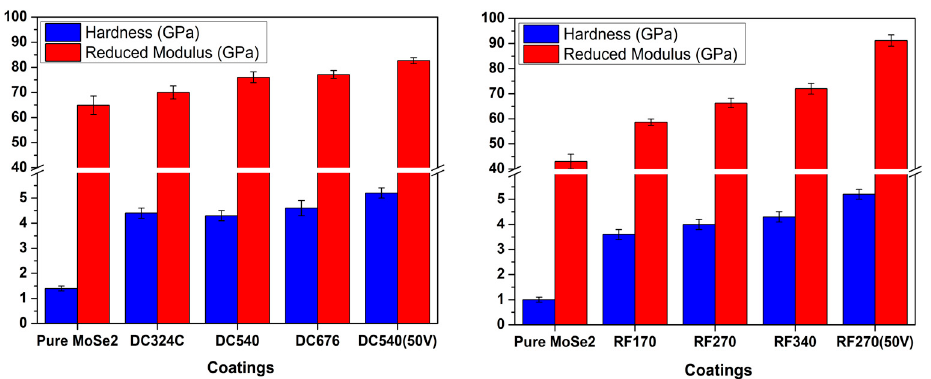
Figure 6. Hardness and reduced modulus of the coatings (case 1-left and case 2-right).